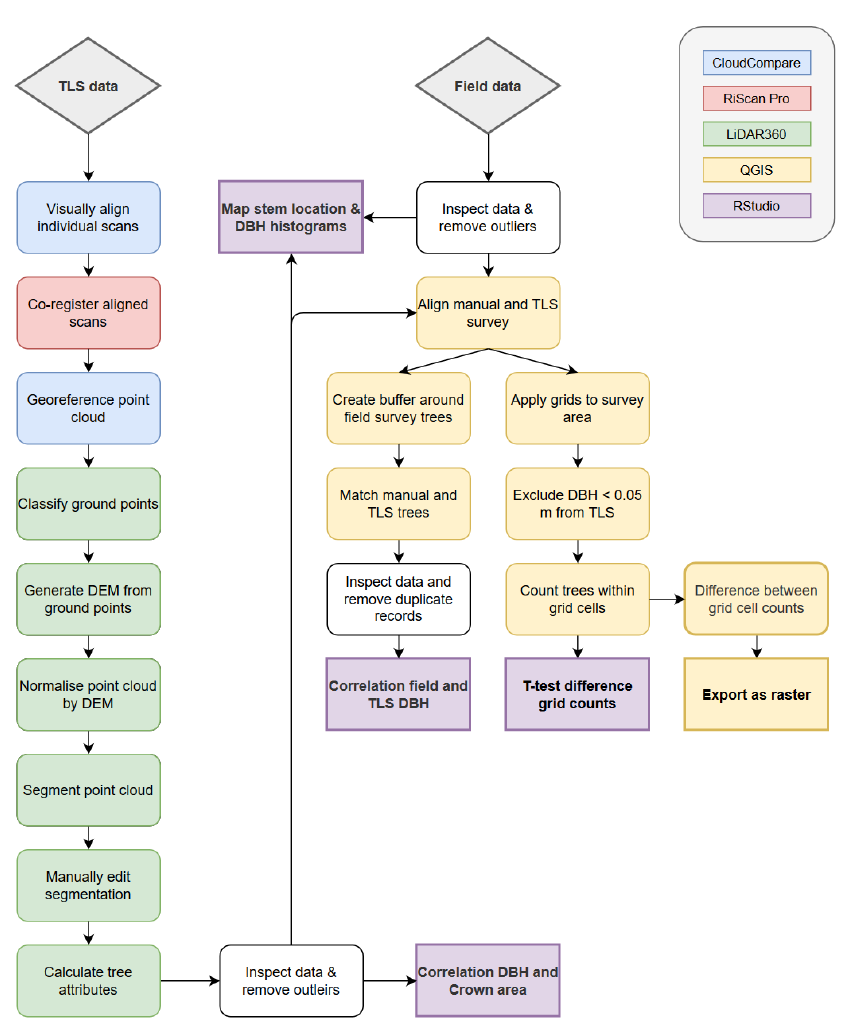
Figure 3. Workflow diagram for point cloud